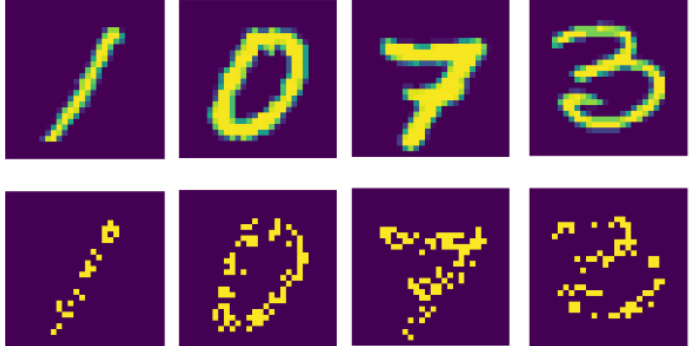
Figure 7. Original images of the MNIST dataset are converted into spikes using Poisson distribution. The upper images show original images, and the below images represent the spike version of original